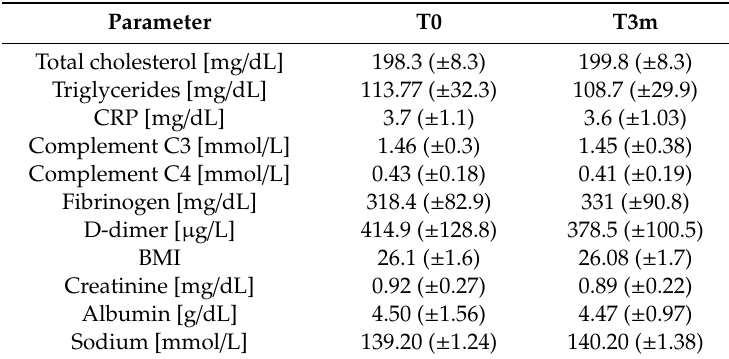
Table 1 . Average values (±SD) of selected physiological parameters in patients before (T0) and after 3 months of diosmin treatment (T3m) .